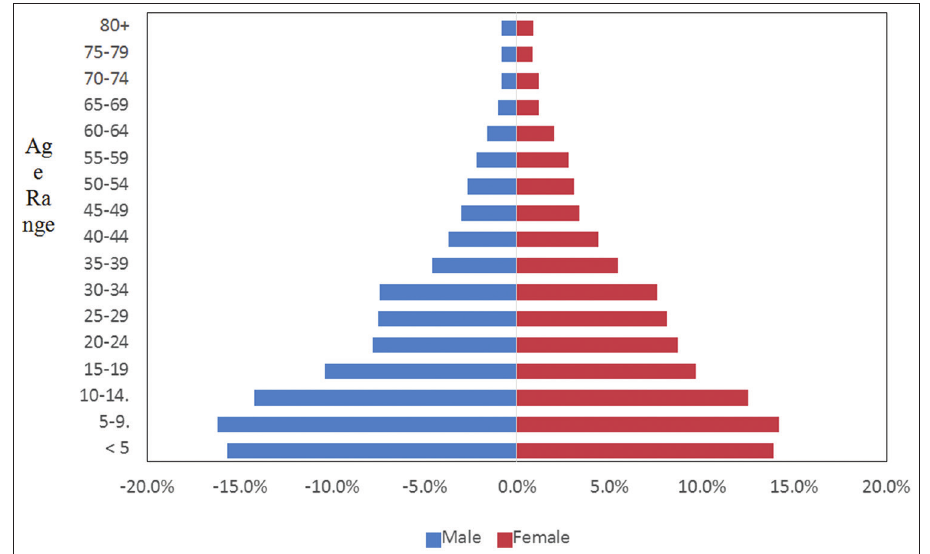
Figure 3 : Population Pyramid of Rwanda